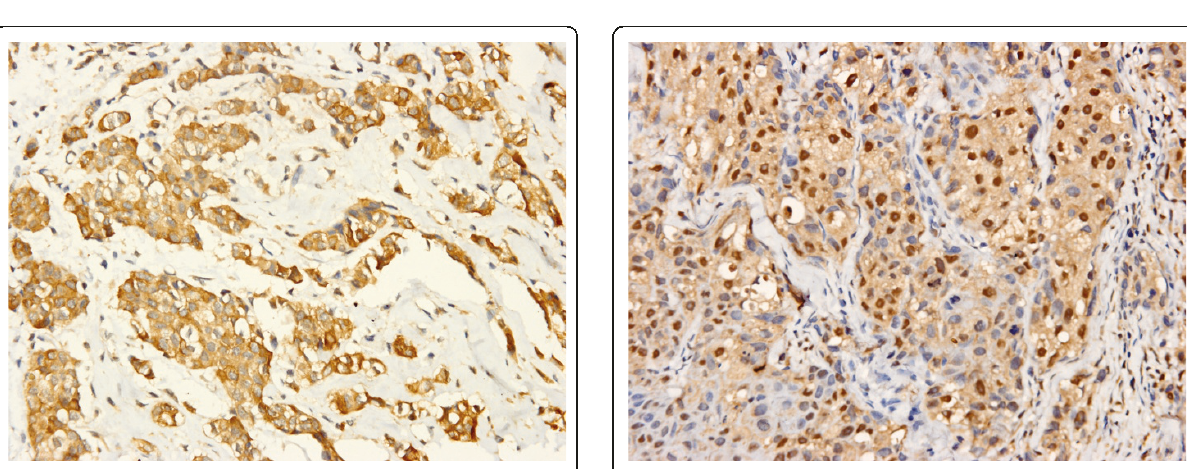
Figure 3 Higher power view of representative nuclear immunostaining of XIAP, in addition to cytoplasmic staining in IDC . Original magnification for this figure: